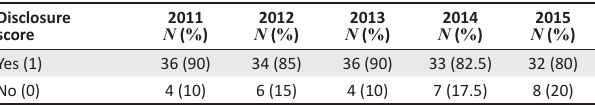
TABLE 1: Director development disclosure scores (2011–2015). Disclosure score